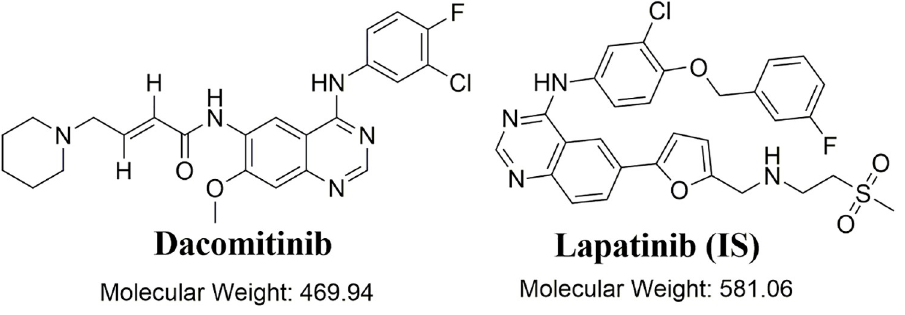
Fig 1. Chemical structures of dacomitinib and lapatinib